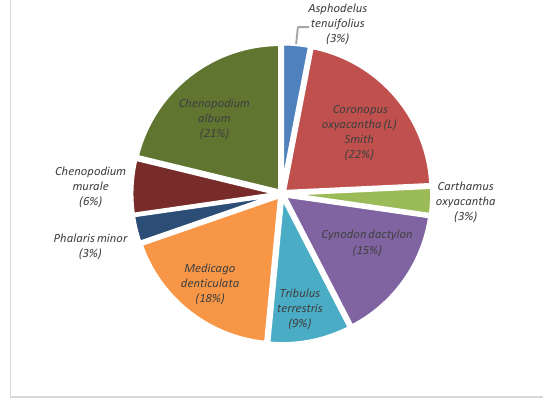
Table 2: Density (%) of weed infesting wheat field at Nawan Kot district Species Name